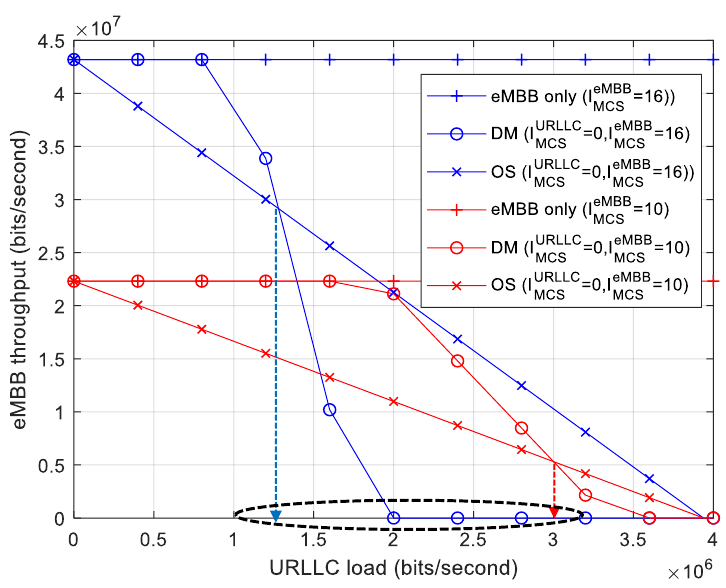
Figure 5. Capacity region with varying the eMBB MCS index: DM vs. OS.